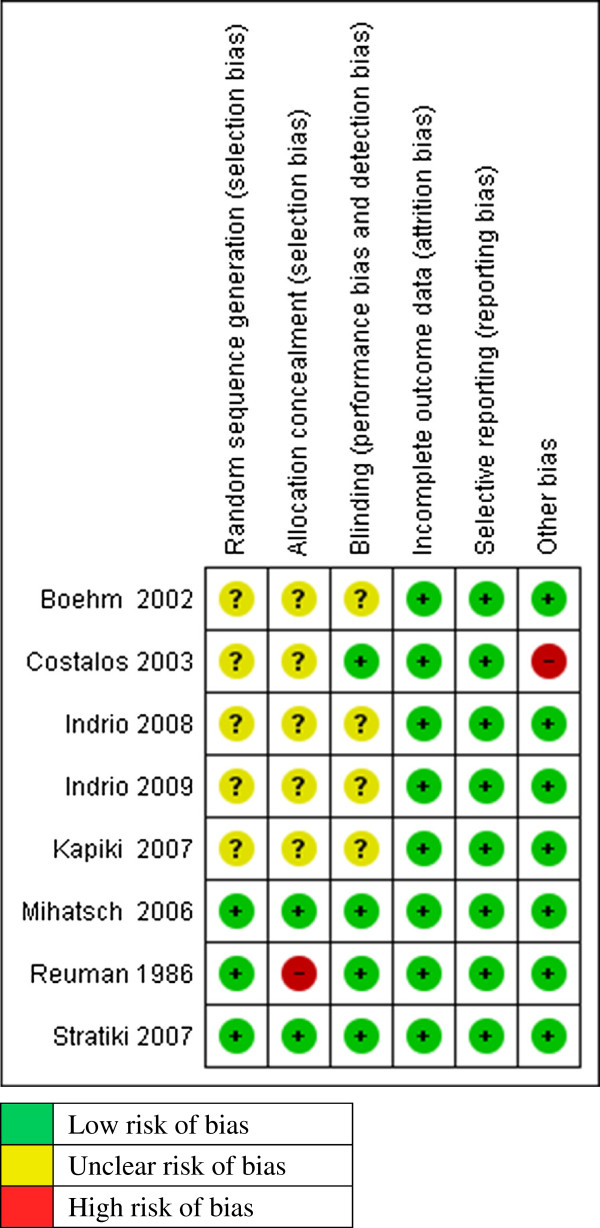
Methodological quality of included studies.